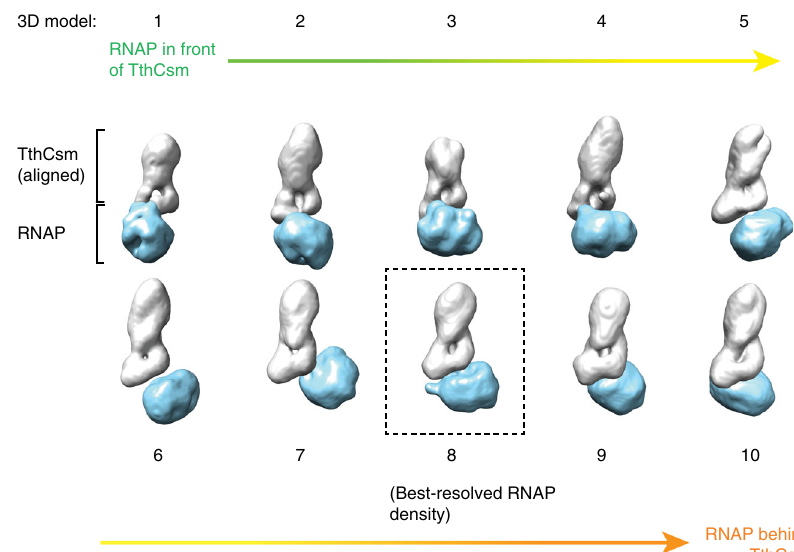
Fig. 2 Visualization of TthCsm tethered at the TEC. Negative-stain 3D EM reconstructions of the TthCsm-TEC complex are shown. TthCsm is colored gray, and the RNAP is colored light blue. The 3D models are numbered from 1-10. The orientation of TthCsm is aligned in all of the 3D models and a colored gradient arrow is used to illustrate how RNAP changes its orientation from in front to behind TthCsm. The boxed model 8, which has the most well- resolved features on the RNAP, was used for structural modeling in Fig.